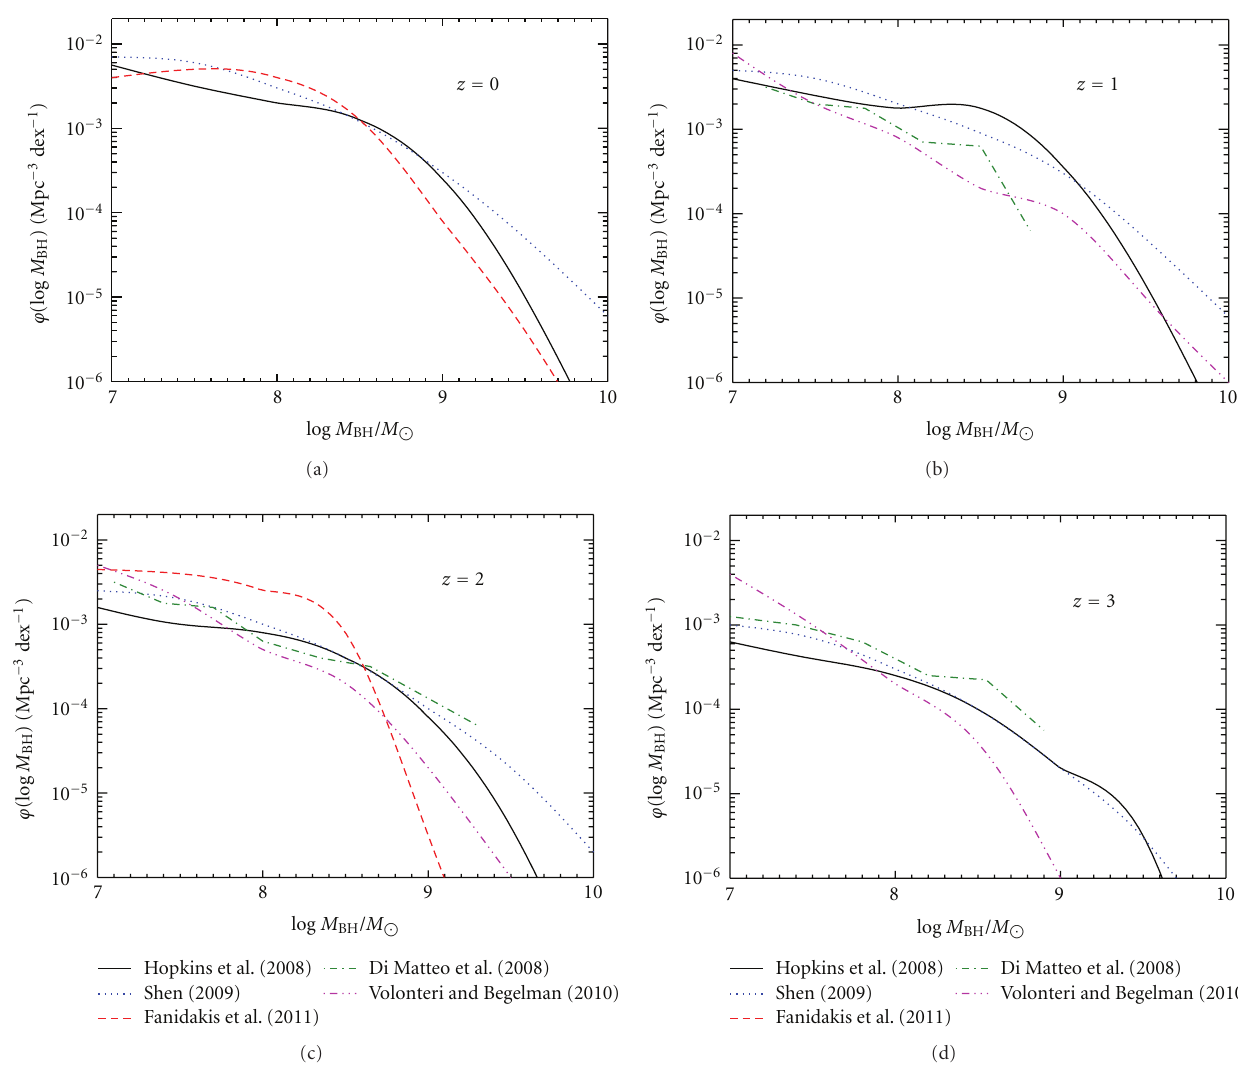
Figure 6: Compilation of BHMFs predicted by several recent models for SMBH formation and growth. Shown are the BHMFs predicted by Hopkinset al. [145] (solid black line), Shen [146] (dotted blue line), Fanidakis et al. [147] (dashed red line), Di Matteo et al. [31] (dot-dashed green line), and Volonteri and Begelman [152] (dashed-dotted-dotted-dotted magenta line). In general the number densities predicted by 10 9 M (cid:10) . Some of these authors did not report BHMFs at each the models agree to within a factor of a few, although they diverge at M BH (cid:0) redshift shown, so we only show those available at each